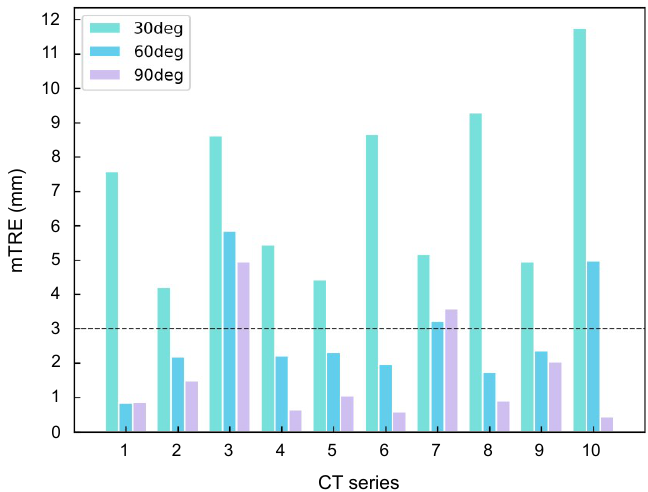
Figure 10. The mTRE of different